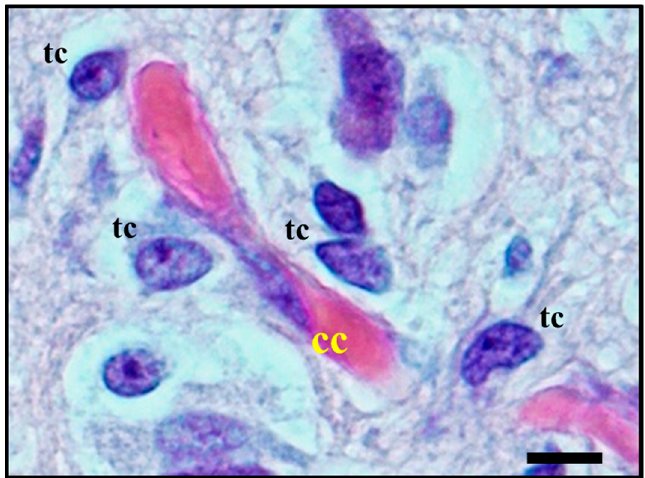
Figure 6. Histological observation of perivascular satellitosis shows atypical glial tumour cells ( tc ) moving and stretching along capillary vessels: a marked increase in nuclear size of endothelial cells ( cc ) is a sign of metabolic reaction to tumour cells aggression. The original image is captured at 400× magnification with a relative region of interest (ROI) reported. The scale bars are 50 µm.